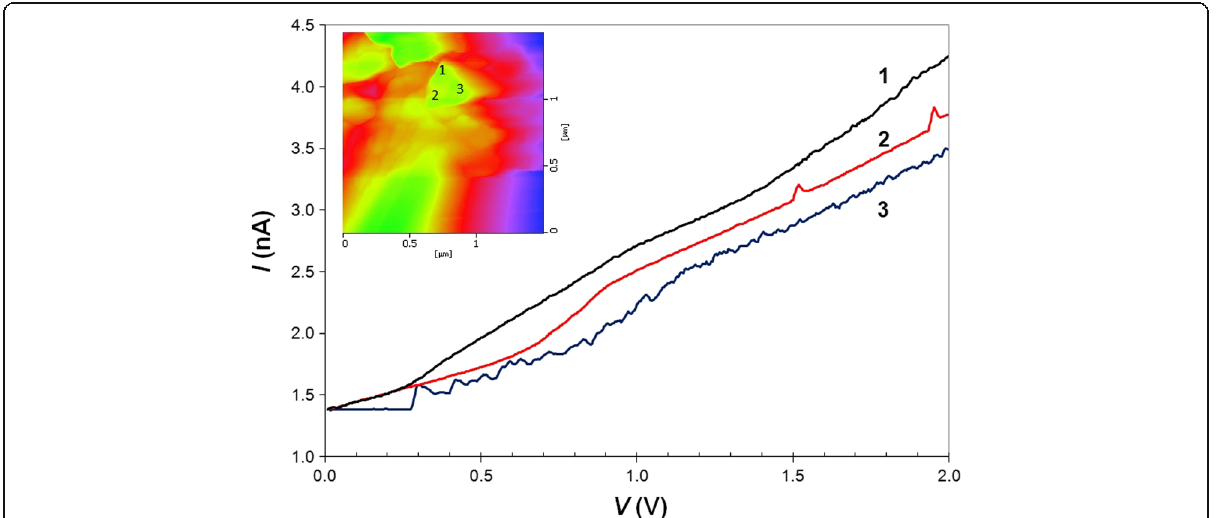
Fig. 10 I – V curves of an individual freestanding SiNW measured by AFM. The characteristics correspond to resistor behavior. The inset shows the AFM scanning area and AFM probe positions for the electrical measurement